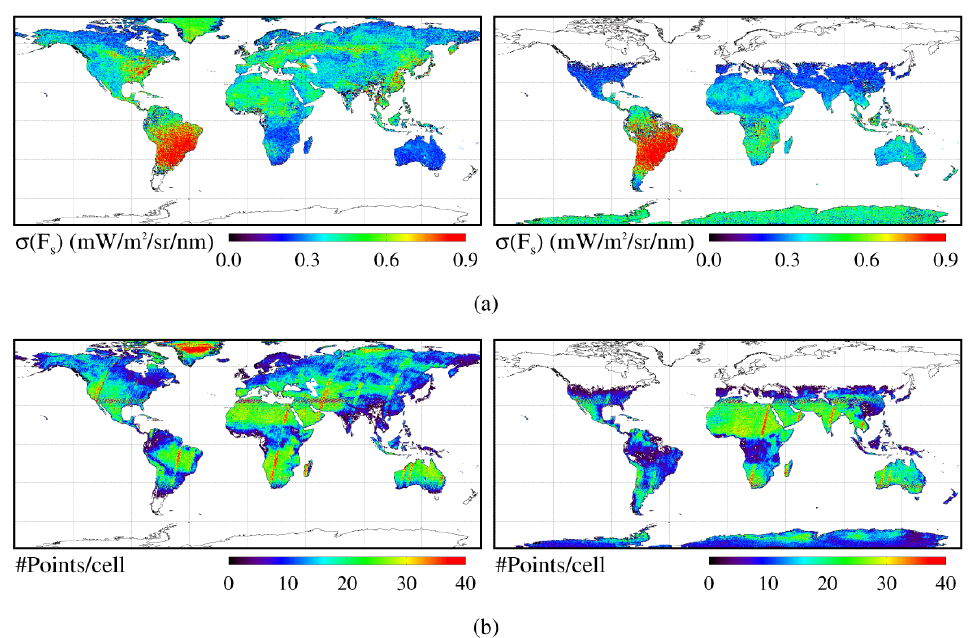
Fig. 16. Global maps of GOME-2 F s retrieval statistical parameters in a 0.5 ◦ grid cell for July (left column) and December (right column) 2009. Each column shows the standard deviation (top) and the number of points per grid cell